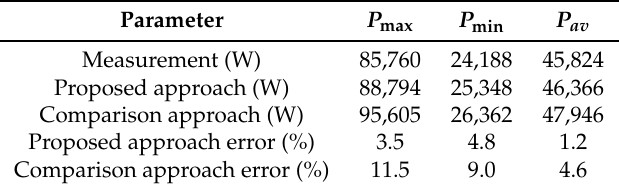
Table 2. Prediction errors of the peak, valley, and average power